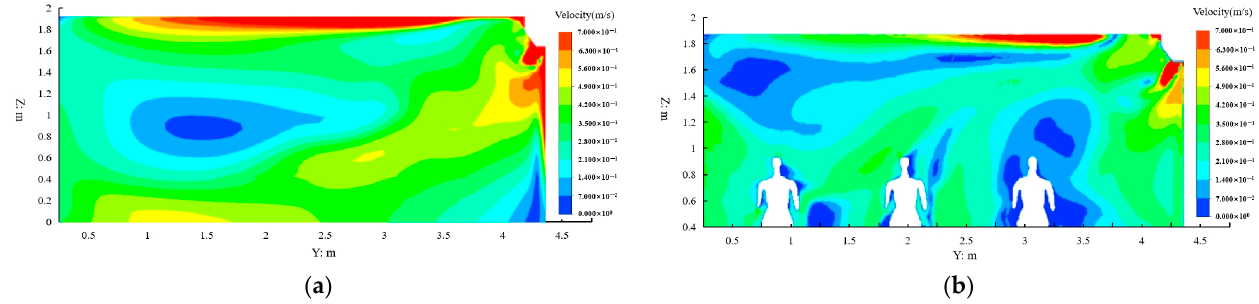
Figure 19. Cloud image of wind speed distribution in manned/unmanned shelter. ( a ) Air velocity of unmanned, ( b ) Air velocity of manned